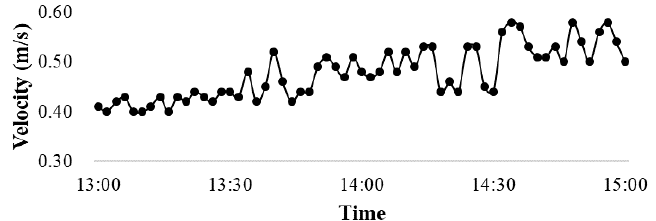
Figure 20. The current velocity during the underwater test.